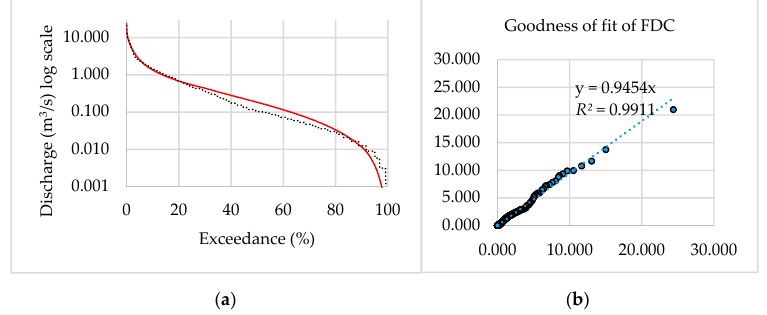
Figure 3. Flow duration curve (FDC) for the observed and simulated daily runoff at station 2FCO5 from 1977 to 2007 ( a ); the correlation between observed and simulated daily runoff ( b ).